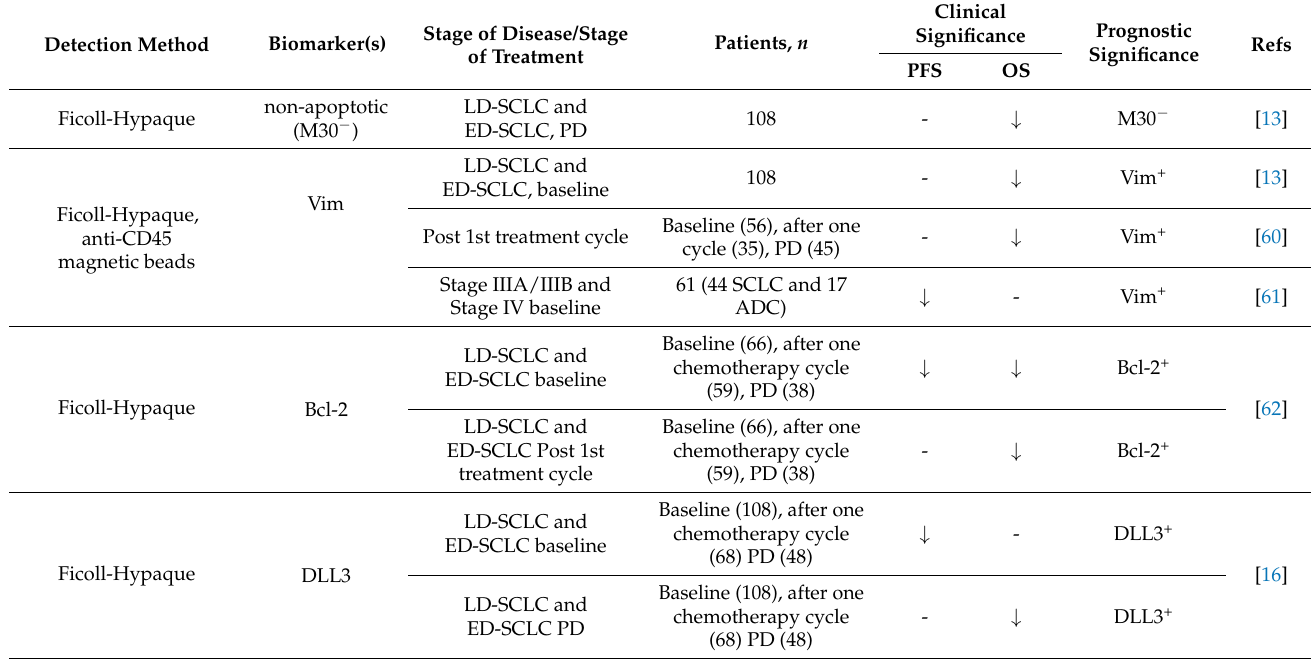
Table 2. Epithelial-to-Mesenchymal Transition (EMT) and EMT-related biomarkers expressed in Circulating Tumor Cells (CTCs) and associated with clinical values of Small-Cell Lung Cancer (SCLC)